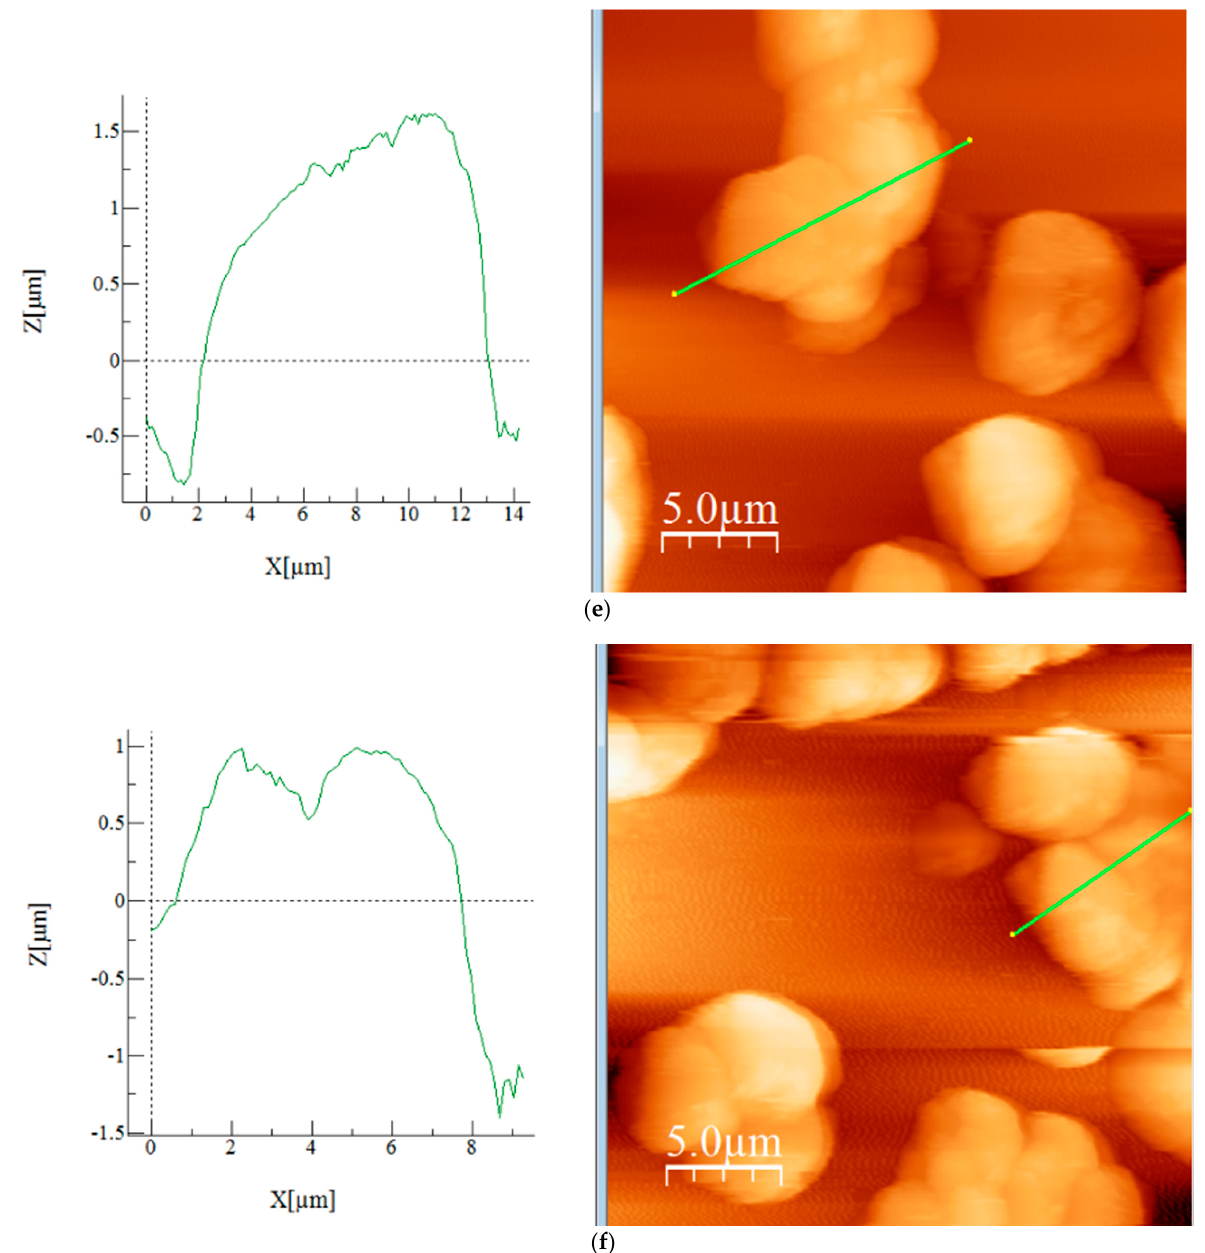
Figure 5. AFM topographical image on a selected area (green line) for sample 1-2 ( a ), 1-7 ( b ), 1-8 ( c ), 1-11 ( d ), 1-13 ( e ) and 1-14 ( f ). Topographical images on the selected areas showed the presence of a porous surface which is visible by the asperities on the graphs. Since the analysed sample on 5 × 5 μ m is a close-up image, the mentioned asperities are more pronounced. More details regarding this aspect is discussed in the roughness section. Table 2. Roughness parameters of sample 1-1, 1-7, 1-8, 1-11, 1-13 and 1-14.